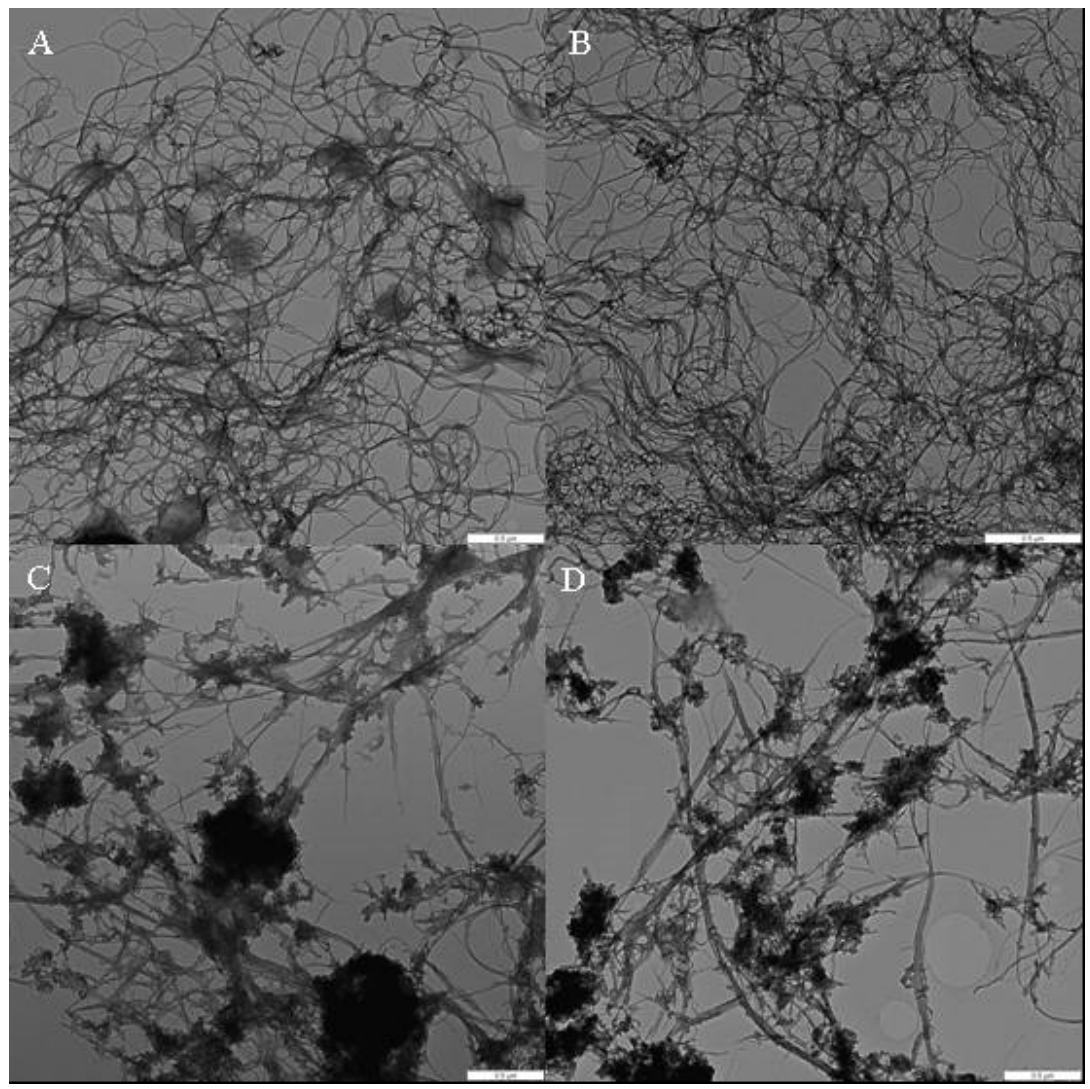
Figure 6. Transmission electron microscopic images of MWCNT/SDS ( A ), MWCNT/DoTAB ( B ), SWCNT/SDS ( C ) and SWCNT/DoTAB ( D ) with scale bars of 0.5 µm. The samples were prepared in a buffer solution Na 2 HPO 4 0.01 M/NaCl 0.02 M, pH 9. Table 1. Zeta-potential ( ζ ), size (d H ) and polydispersity index (PDI) values for different carbon nanotubes in the presence and absence of ionic